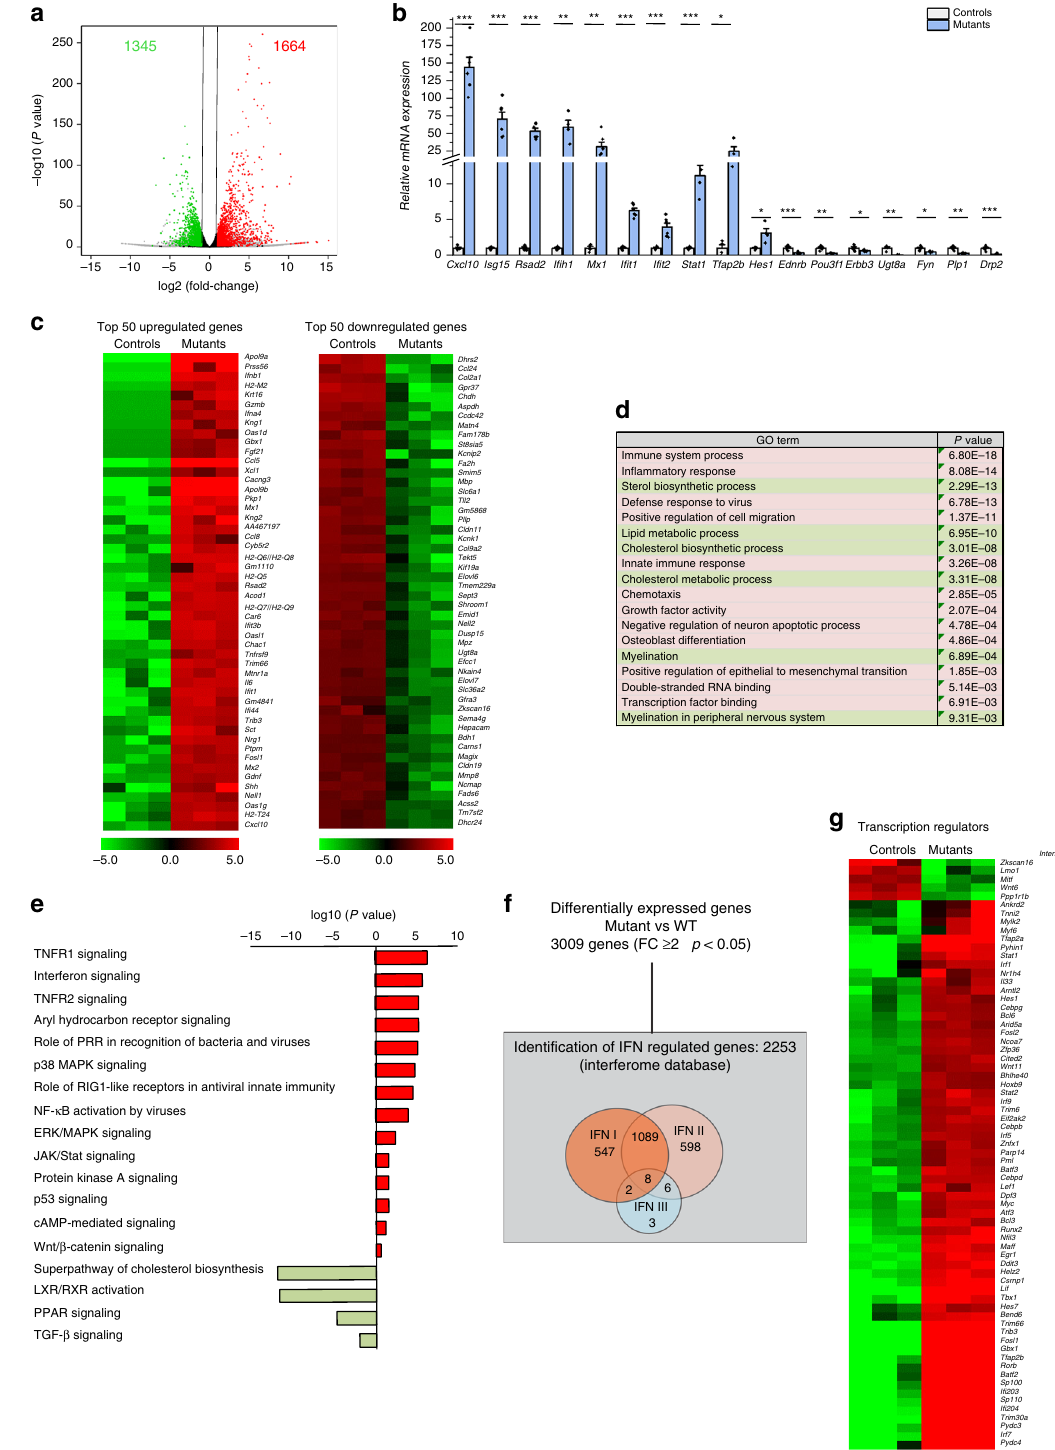
mutants within or near 57 different genes in our RNA-seq dataset (Supplementary Data 3). Only six of these sites were previously reported in the RADAR or DARNED databases, suggesting that most of the identi fi ed sites may be regulated in a tissue-speci fi c manner. RNA editing sites led to amino-acid change, intronic, splice acceptor site or 3 ′ UTR variants with similar frequency. Only seven of the 57 targets showed deregulation of over twofold.